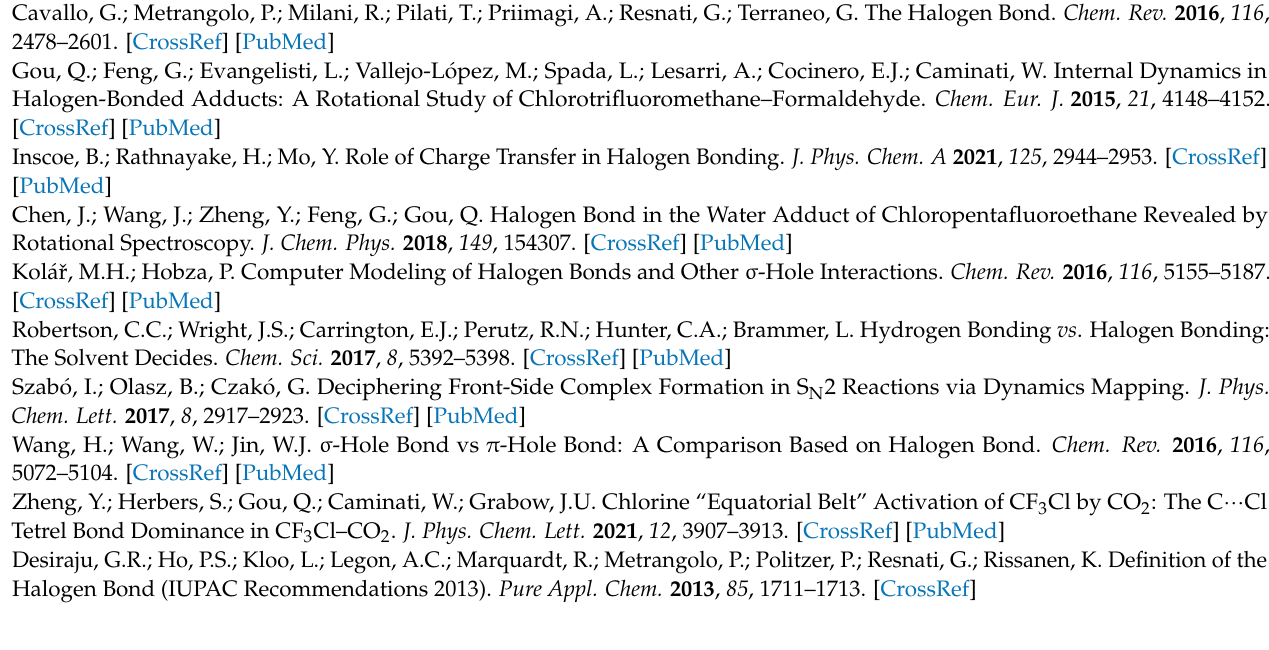
anion. Figure S2: CID fragments of the Mn(CO) 5 − anion. Figure S3: Optimized structures of CH 3 I − Mn(CO) 3 − . Figure S4: Additional conformers of RC. Coordinates of all computed